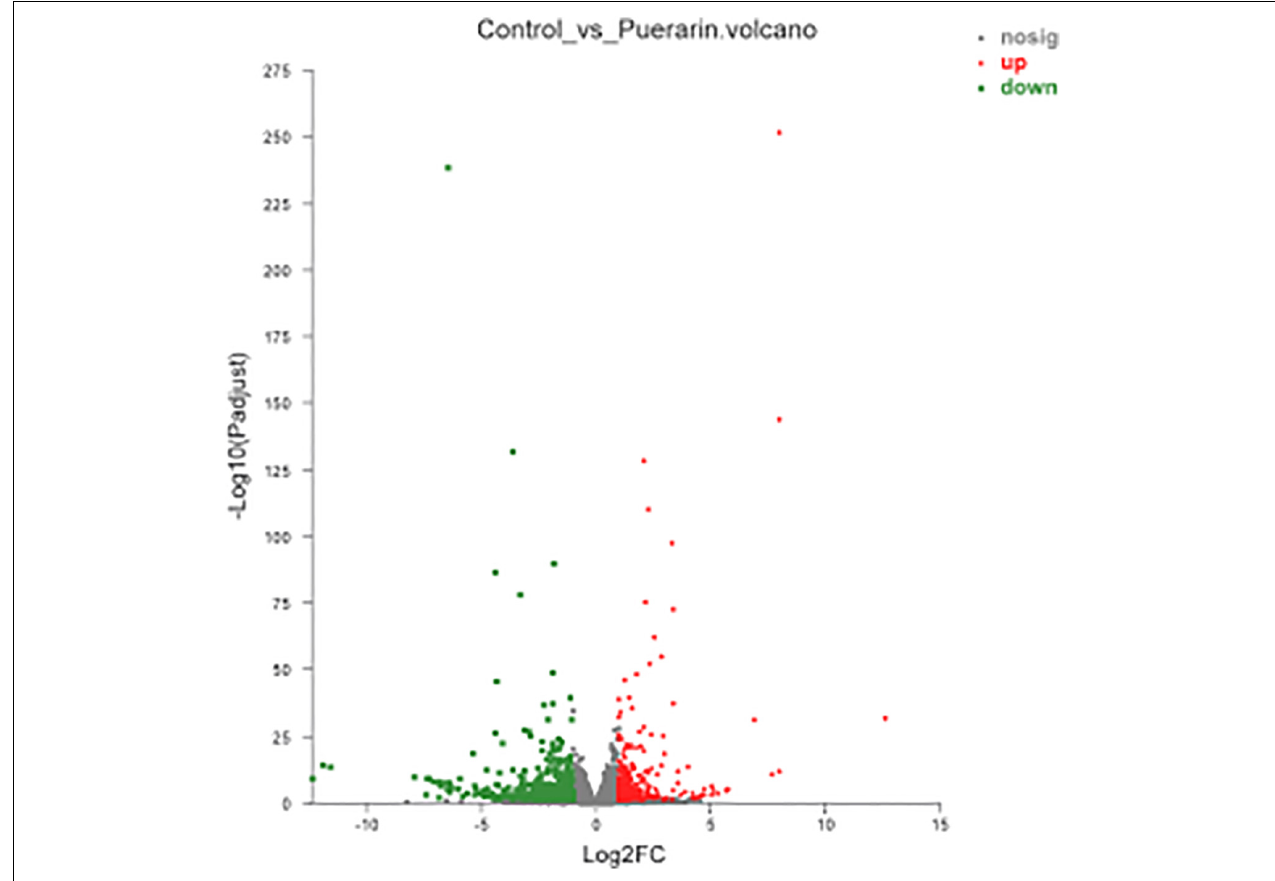
FIGURE 3 | Volcano plot of the differentially expressed genes between control and Puerarin groups of longissimus thoracis muscles ( n = 4). Control: dietary supplementation with 0 mg/kg Puerarin in the feed concentrate; Puerarin : dietary supplementation with 400 mg/kg Puerarin in the feed concentrate. The red dots represent the up-regulated DEGs, the green dots represent the down-regulated DEGs and the blue dots represent non-DEGs.